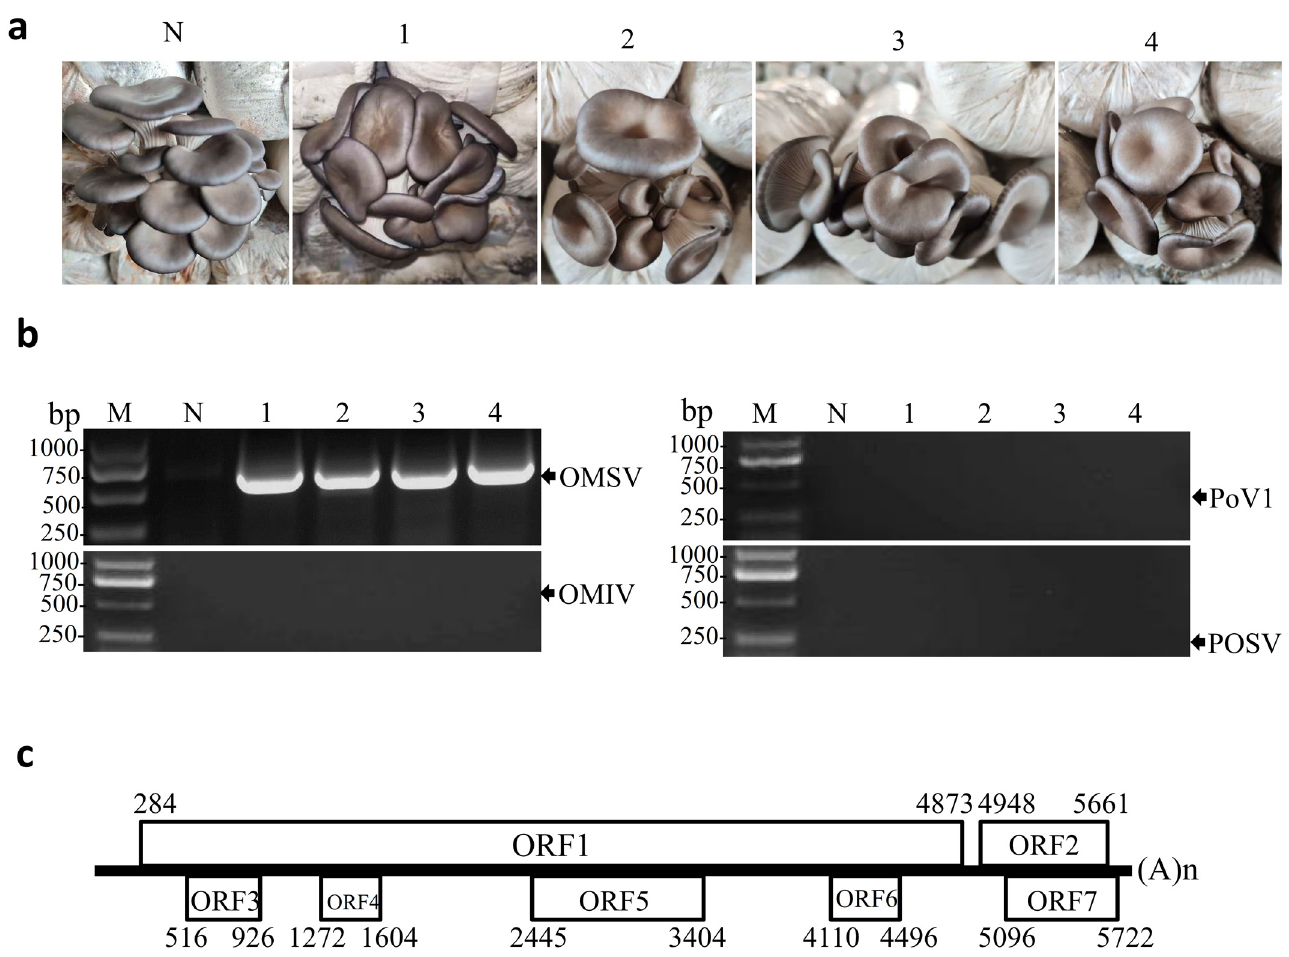
Figure 1. RT-PCR detection of OMSV in malformed fruiting bodies of P. ostreatus . ( a ) The collected fruiting body samples from P. ostreatus cultivar 8129 display symptoms of funnel-shaped or morning glory–shaped caps. ( b ) RT-PCR detection for the presence or absence of OMSV, OMIV, POSV, or PoV1 from fruiting body samples described in ( a ). Lanes 1–4, four fruiting body samples of P. ostreatus that were positive for OMSV by RT-PCR. N, negative control, the healthy P. ostreatus sample; M, GL DNA Marker2000. ( c ) Schematic representation of the OMSV-Ch genome structure. Boxes represent the ORFs. Numbers represent nucleotide positions.